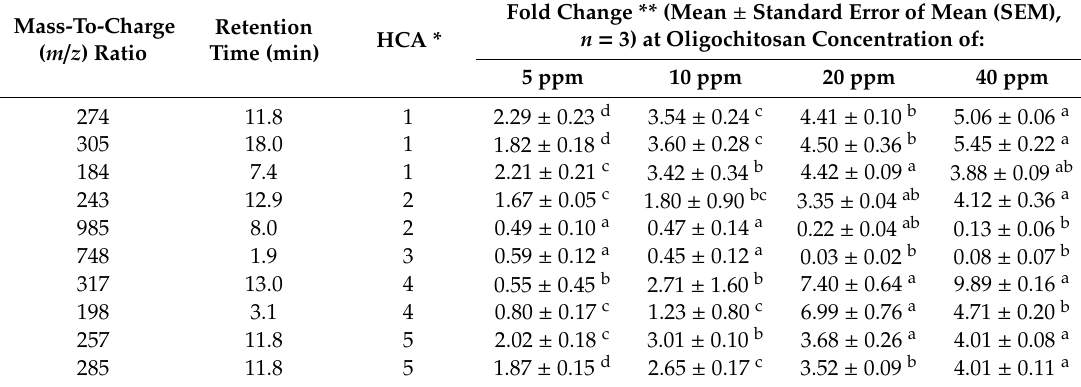
Table 1. List of the ten highest and most significantly changed m / z signal